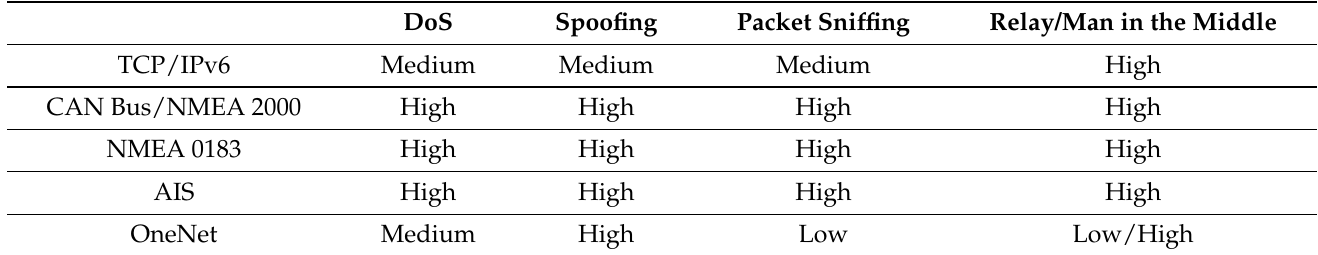
Table 2. Summary of marine network protocols and their respective security risk